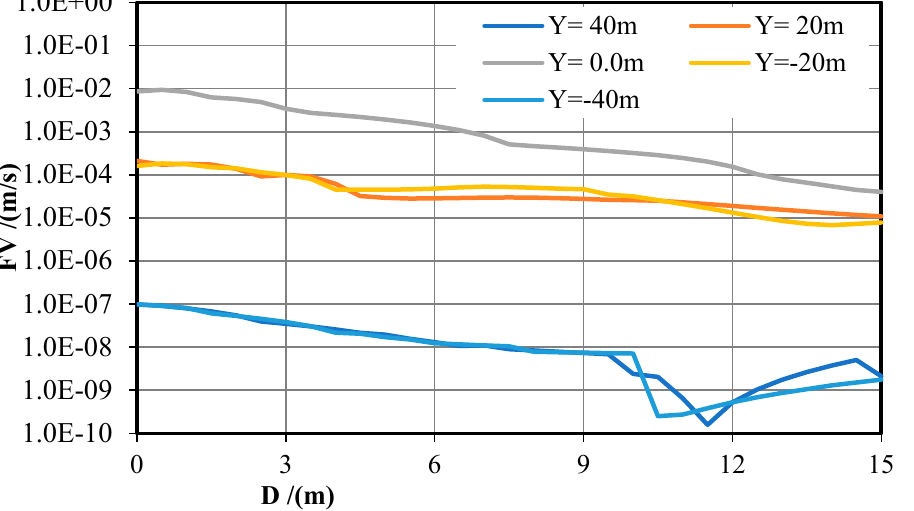
Figure 13. FV as a function of D with various relative positions. Table 3. Water inflow rates with various relative locations of the intersecting faults. Location of the Fault